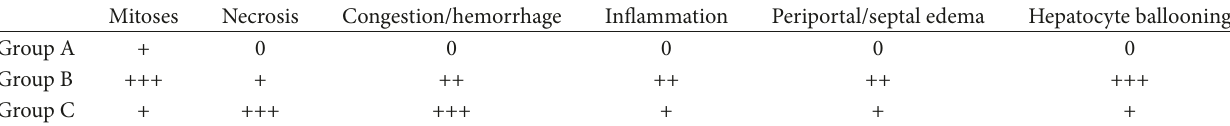
Table 3: Scored pathological features.